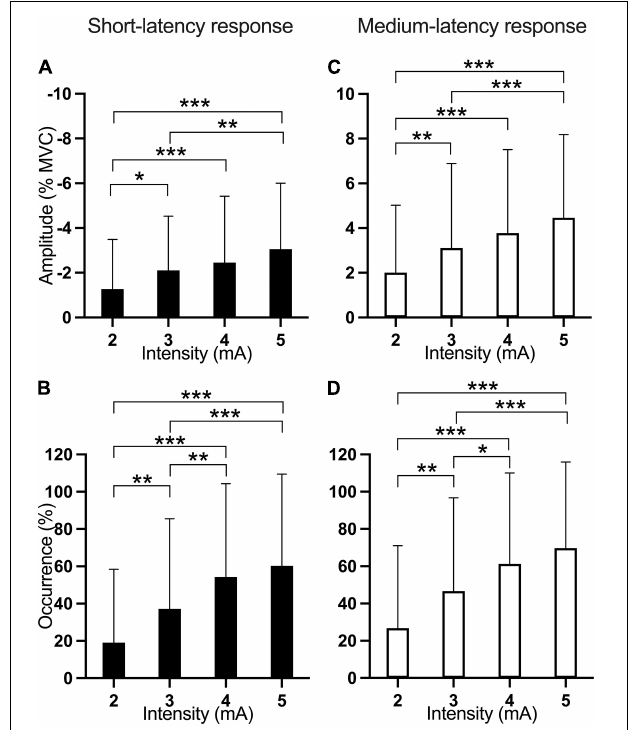
FIGURE 4 | Mean amplitude and occurrence of the short- and medium-latency responses according to current intensity (rotation and stimulus duration pooled within each EVS intensity). The first column of figures (A,B —black) is associated with the short-latency response while the second one (C,D —white) is associated with the medium-latency response. The first line of figures represents the amplitude (A,C) of the response while the second one represents the occurrence (B,D) . * p < 0.05; ** p < 0.01; *** p < 0.001.